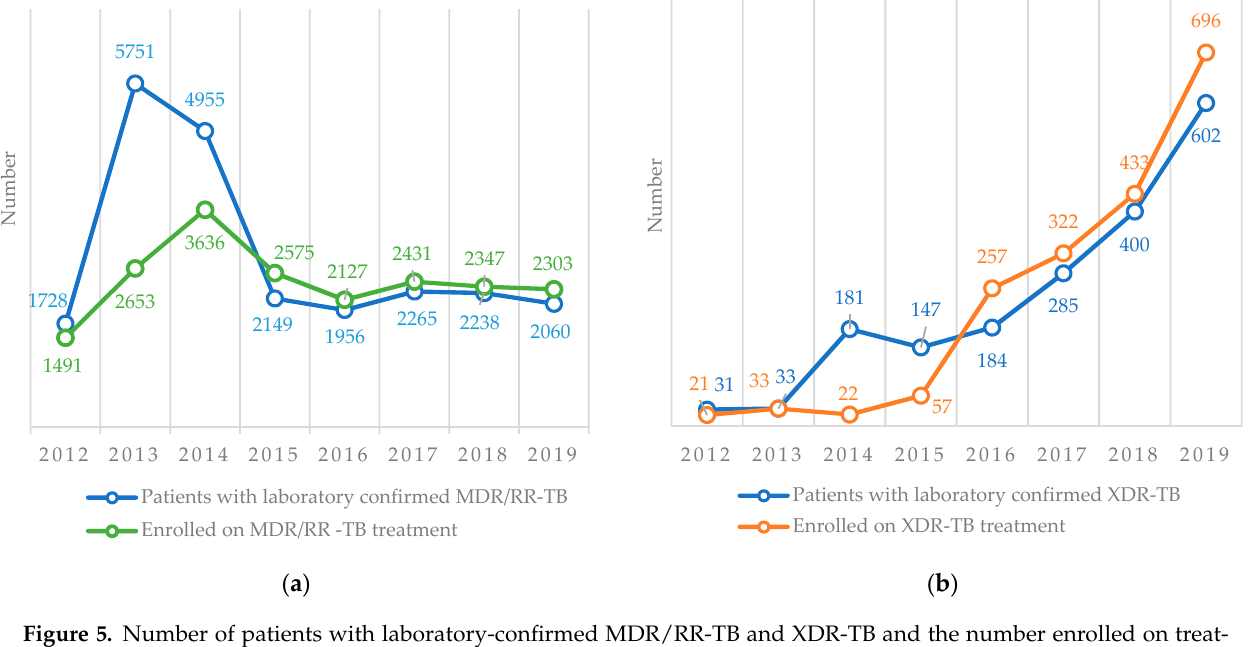
Figure 5. Number of patients with laboratory-confirmed MDR/RR-TB and XDR-TB and the number enrolled on treat- ment in Uzbekistan from 2012–2019. ( a ) MDR/RR-TB, ( b ) XDR-TB. TB = tuberculosis, MDR/RR-TB = multidrug- resistant/rifampicin-resistant TB, XDR-TB = extensively drug-resistant